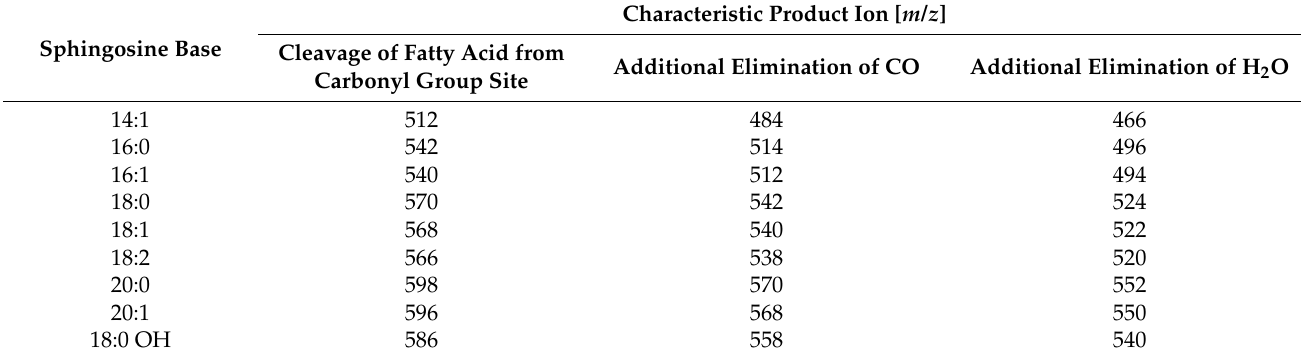
Table 2. Characteristic product ions of hydroxylated sulfatides (i.e., ion cluster).